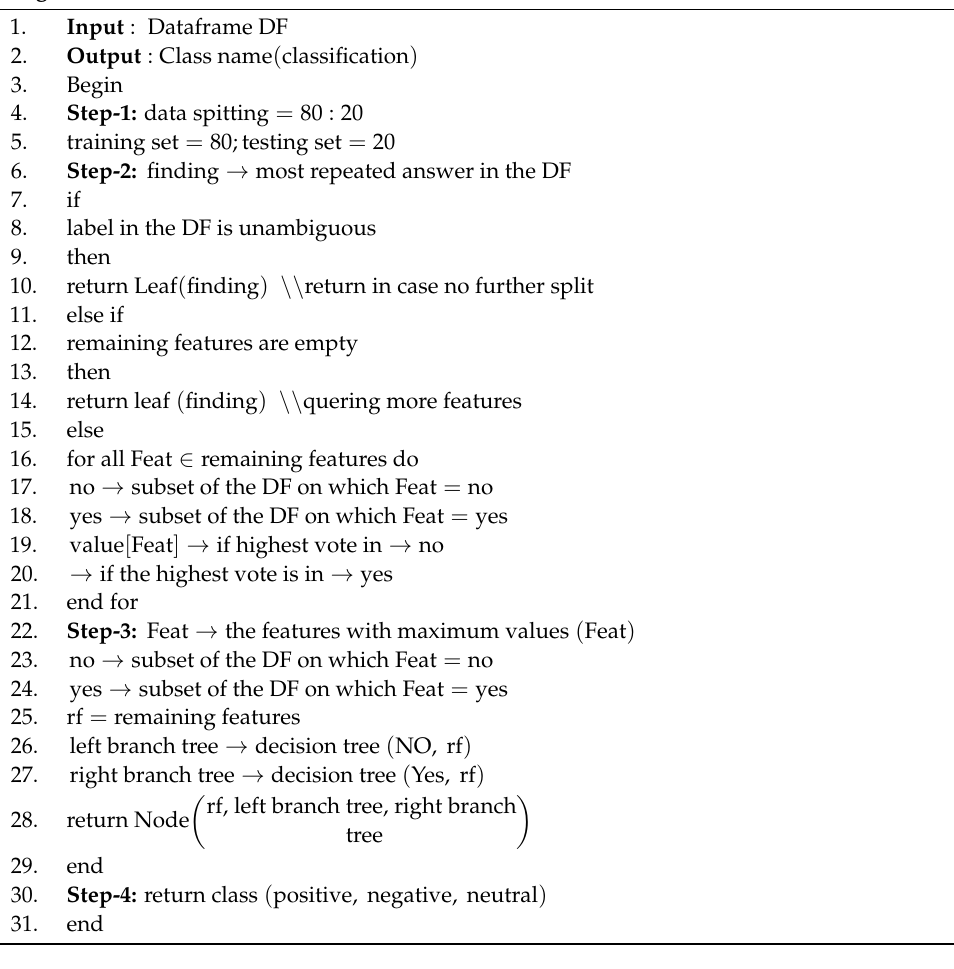
Algorithm 4: K-Nearest